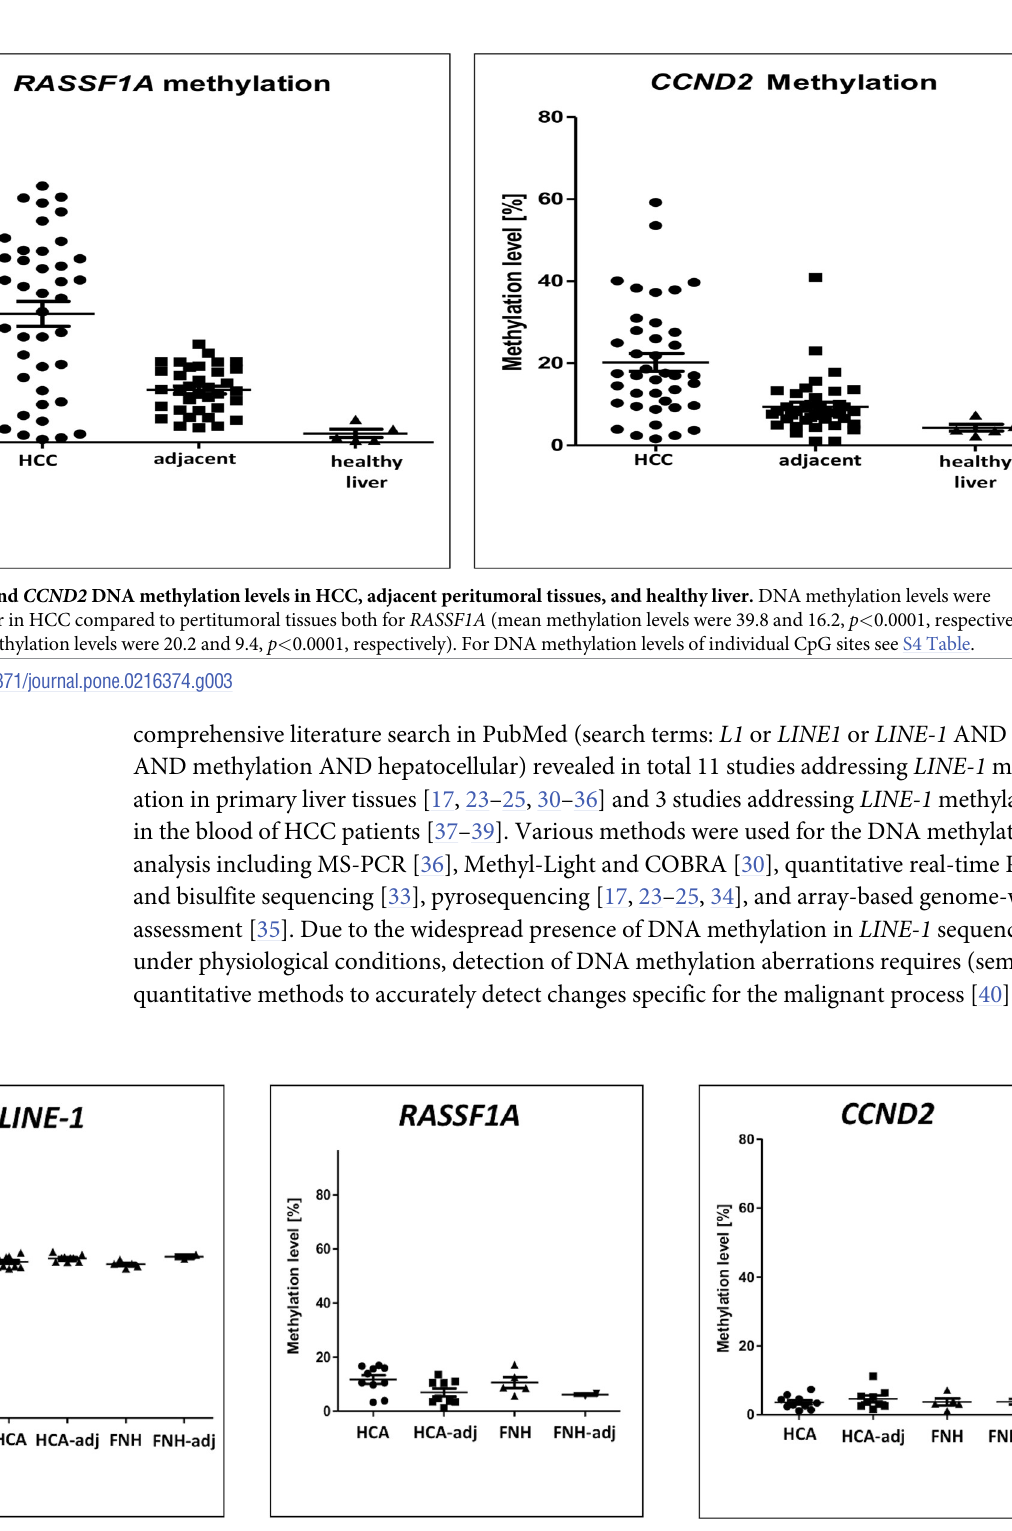
Fig 4. LINE-1 , RASSF1A , and CCND2 DNA methylation in benign liver tumors (HCA and FNH) and the adjacent peritumoral tissues. DNA methylation levels at the LINE-1 , RASSF1A , and CCND2 loci were not significantly different in benign liver tumors and the peritumoral tissues. For DNA methylation levels of individual CpG sites see S5